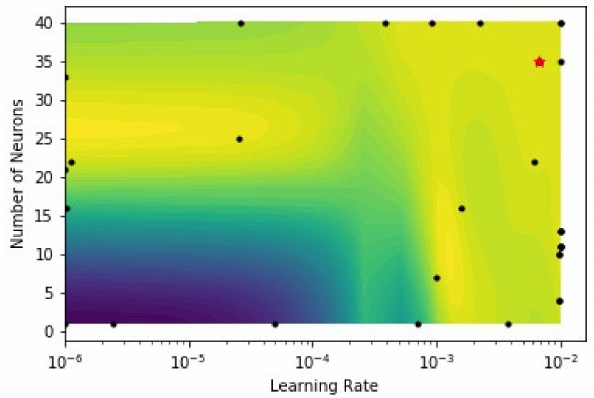
Figure 4. Optimized BNN learning rate plotted with number of neurons in each layer.